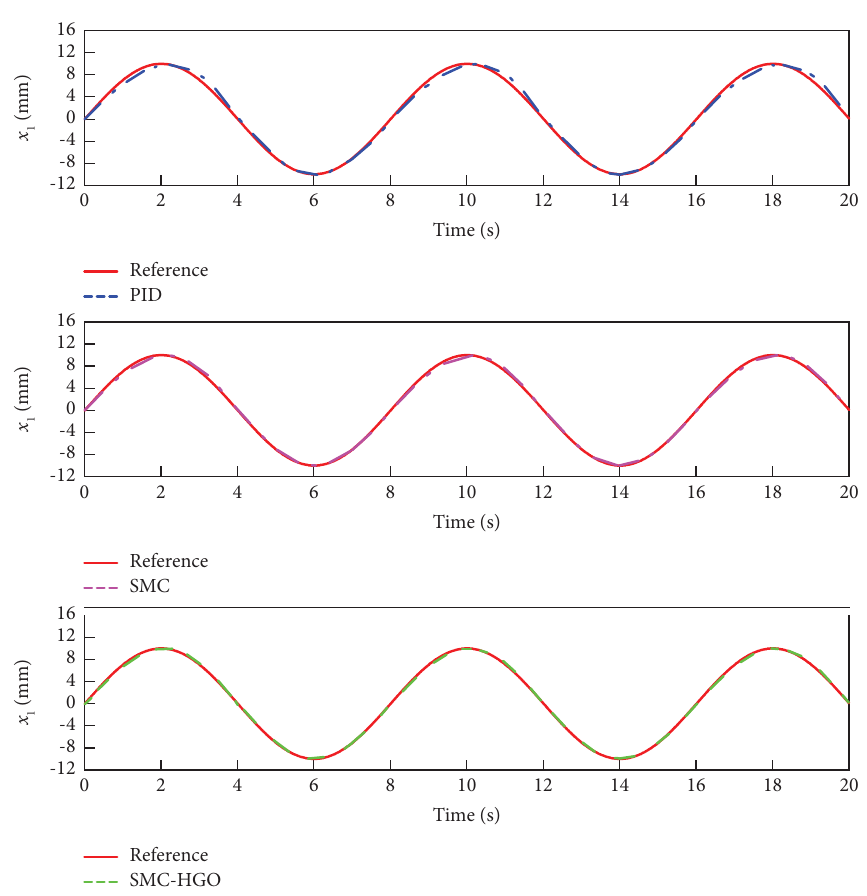
Figure 3: Comparative tracking performance of sinusoidal